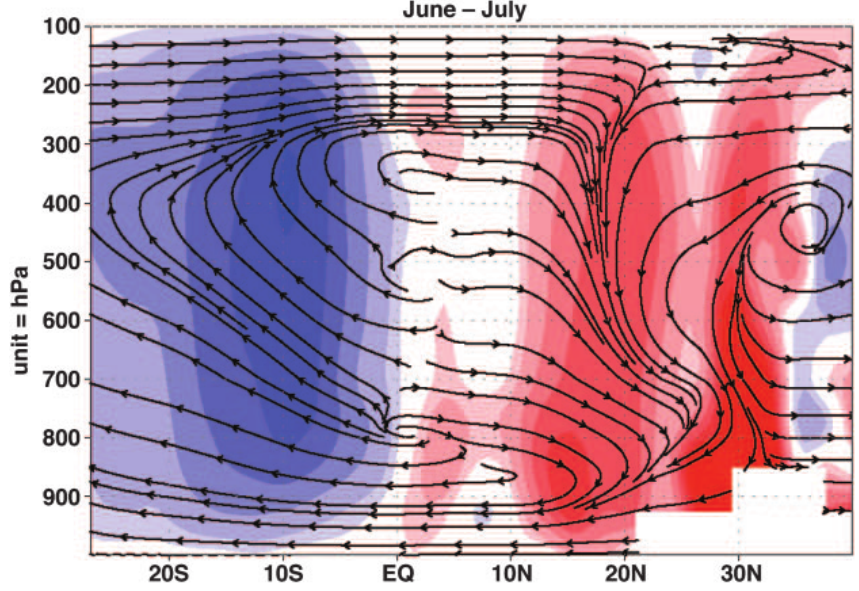
Fig. 41. Simulated changes in the meridional circulation due to the effects of the Asian-ABC for June and July 1985–2000, averaged over 60 ◦ E–100 ◦ E; red indicates increased sinking motions, blue increased rising motions (from Ramanathan et al., 2005, copyright 2005 by the National Academy of Sciences, USA, reproduced with